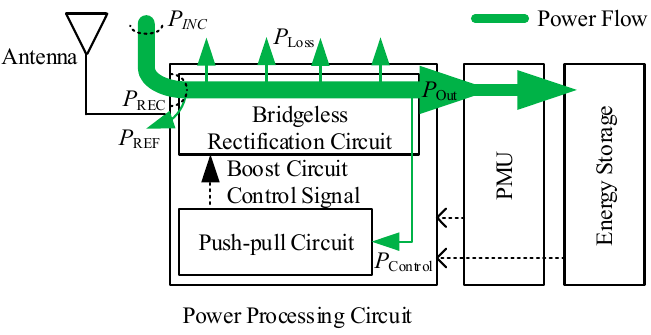
Figure 1. The general block diagram of the proposed system.